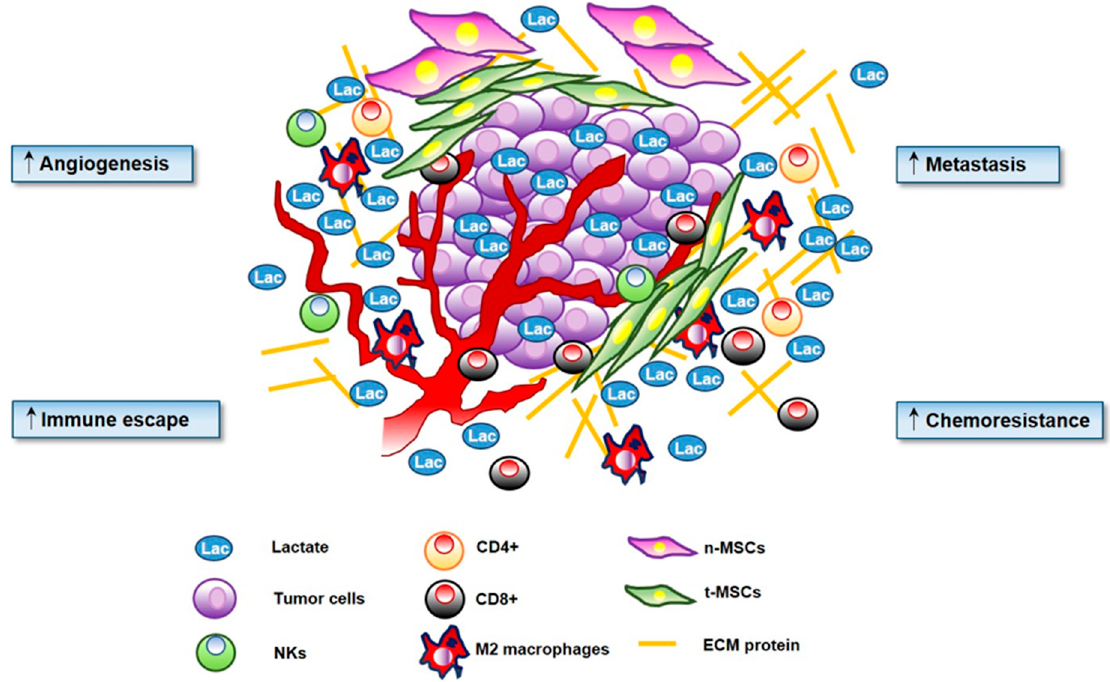
Figure 1 . Lactate has a key role in cancer progression. Microenvironmental secreted lactate increases angiogenesis, motility and migration of cancer cells. Lactate is directly involved in the ‘immune escape’ by decreasing activation of T cells and promoting Treg proliferation. Lactate increases extracellular acidosis of the tumor microenvironment (TME) stimulating chemoresistance.